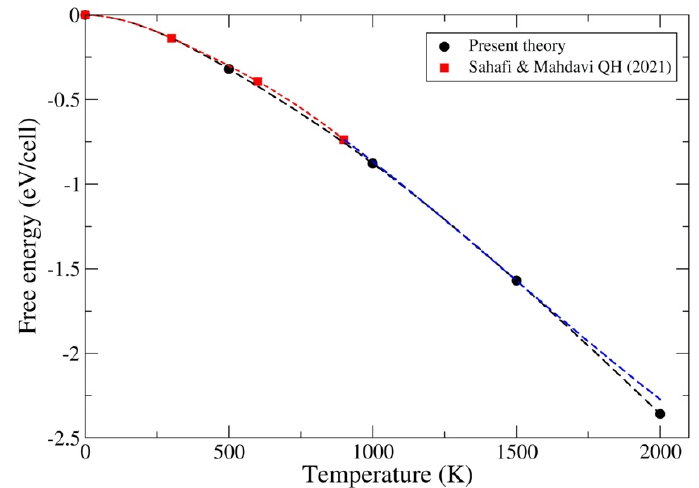
Figure 1. Free energy for ThC from present theory together with results from a first-principles quasi- harmonic (QH) model [4] where the blue dashed curve (above 900 K) is a cubic-spline extrapolation. Results are solid symbols and dashed lines are guides for the eye only.